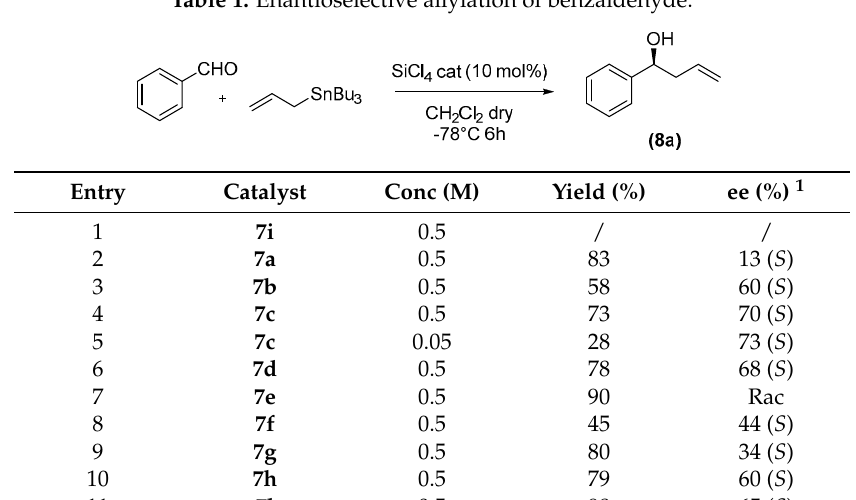
Table 1. Enantioselective allylation of benzaldehyde.